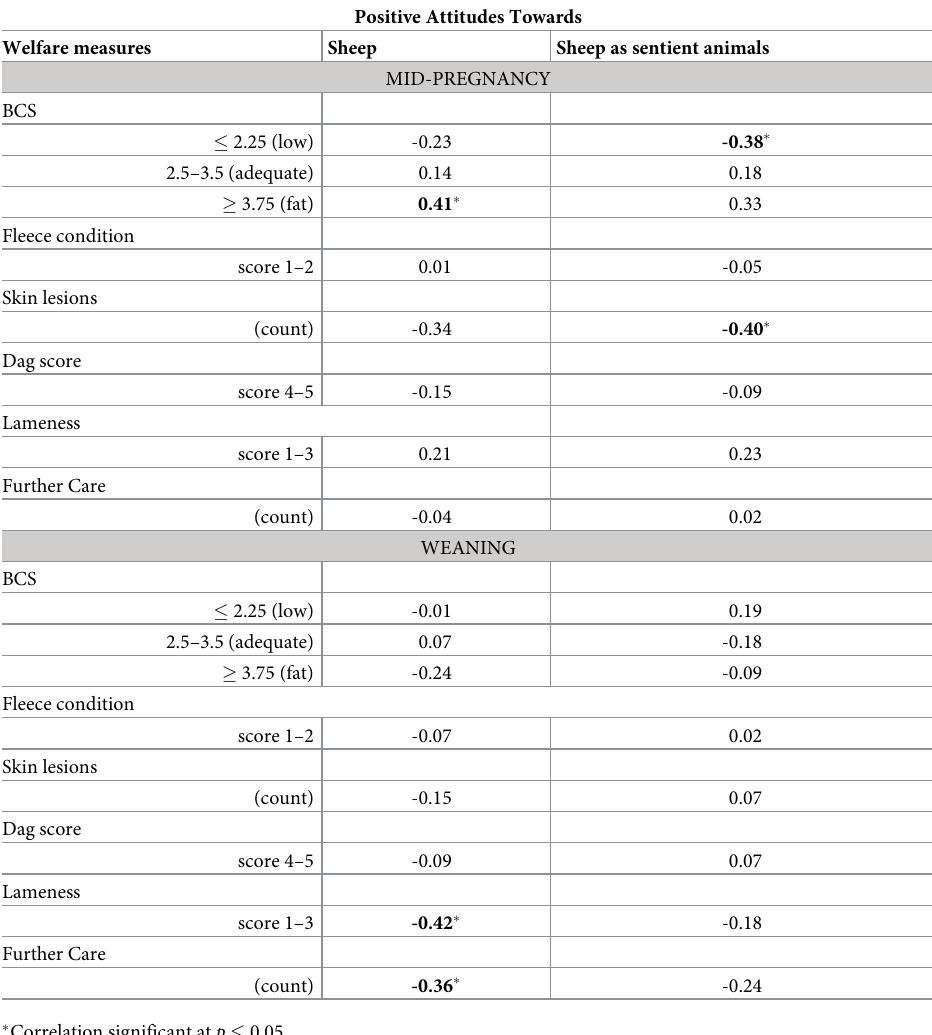
Table 5. Spearman’s rank correations between general attitudes towards sheep and welfare